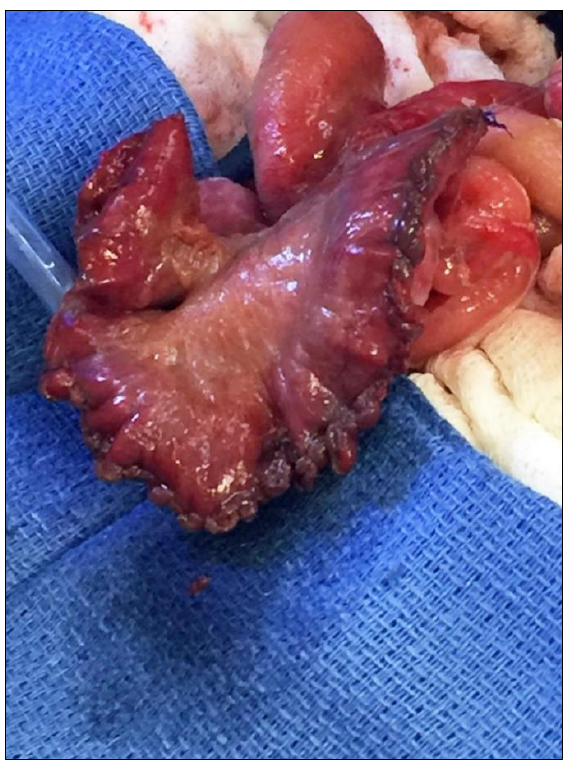
Figure 1. Targeted anti-mesenteric resection of necrotic bowel and tubularization over 16Fr